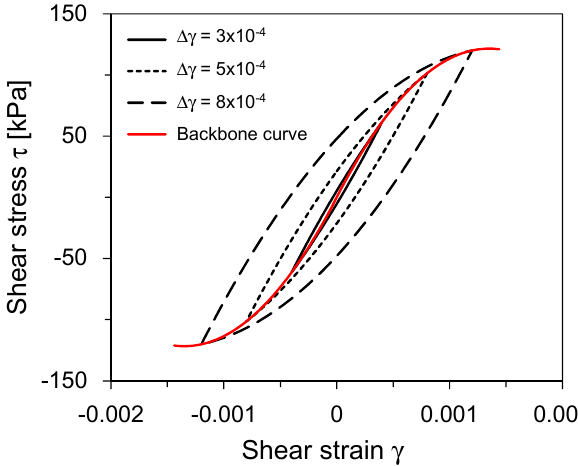
Figure 1. Nonlinear stress-strain behavior of soil subjected to three different shear strain amplitudes. The hysteretic loops and backbone curve are obtained using Equations (1) and (3). The model parameters are G max = 180 MPa, α = 370, and n = 2.